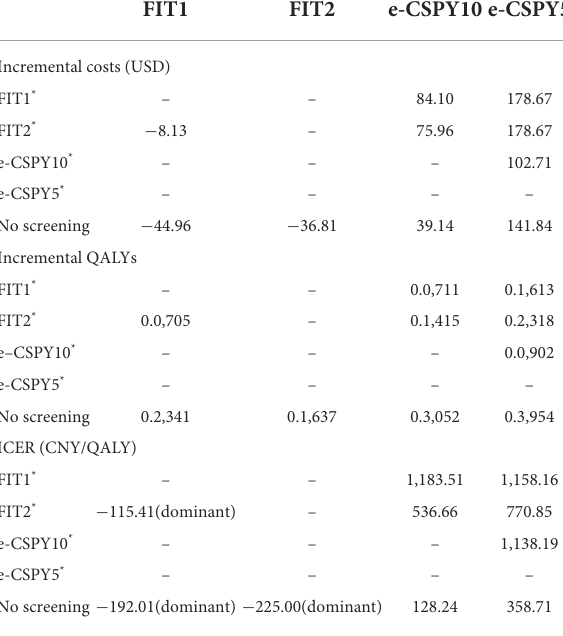
TABLE 4 Results of the base case